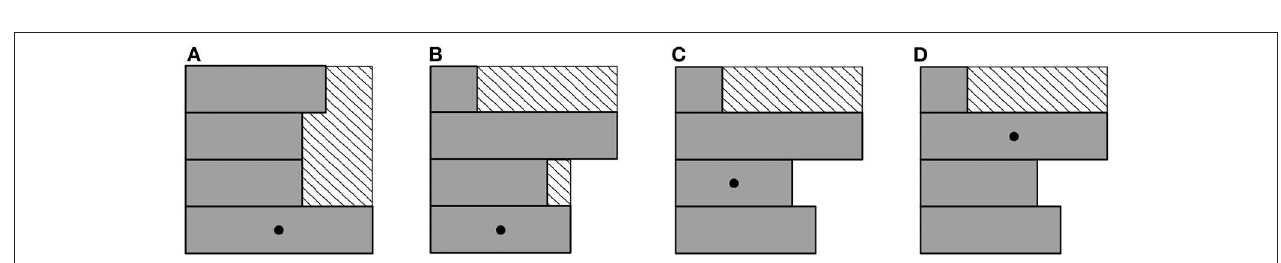
FIGURE 2 | Convex hull as the fictitious plane for the equilibrium of (A) block 1, (B) block 2, (C) block 3, and (D) block 4.